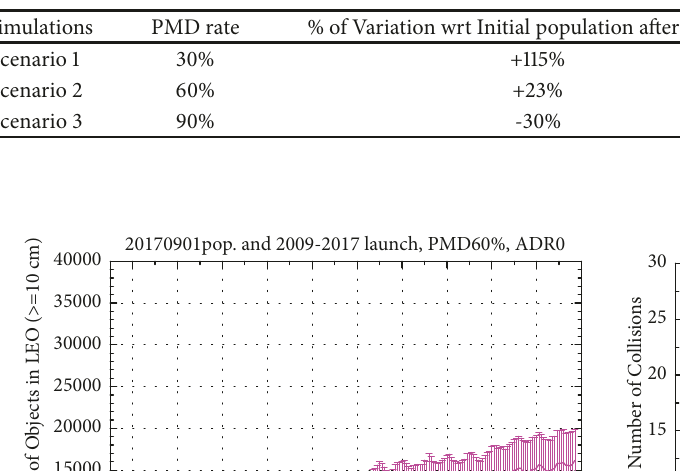
Table 2: Quantification of evolution results of the three scenarios simulated by SOLEM model.